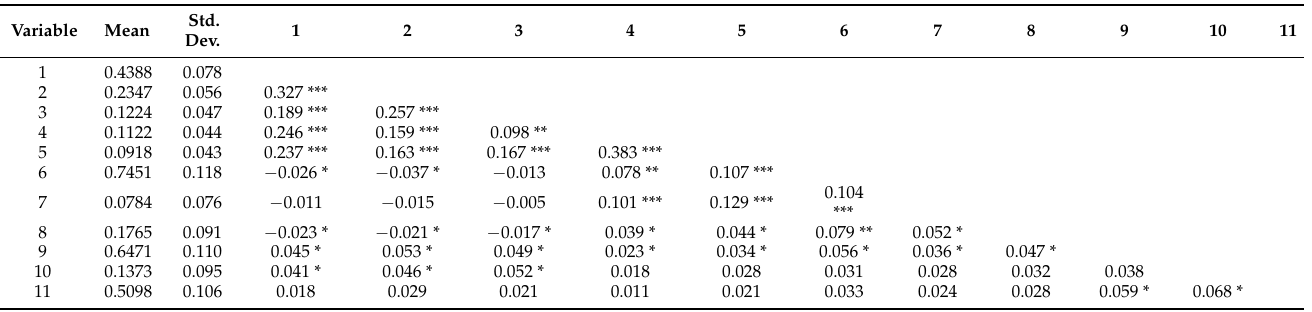
Table 5. Correlations between open-innovation